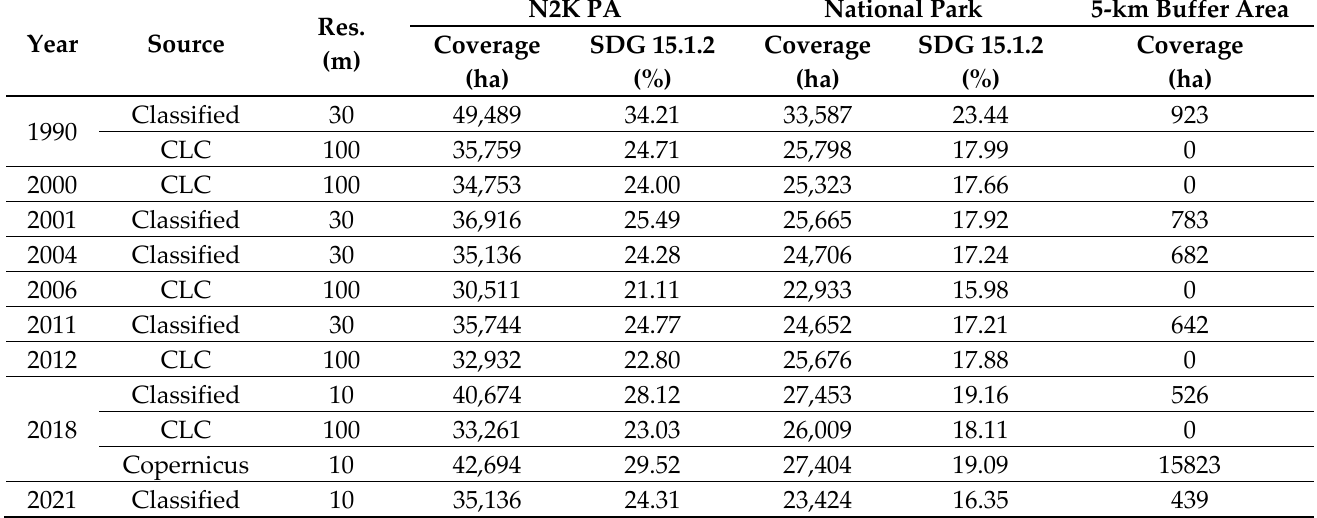
Table 5. Grasslands coverage and SDG 15.1.2 indicator resulting from time series of LC classified mappings, CLC and Copernicus HR products analysed within the N2K PA and the national park boundaries. In addition, grasslands coverage within the 5-km buffer area surrounding N2K PA boundary is